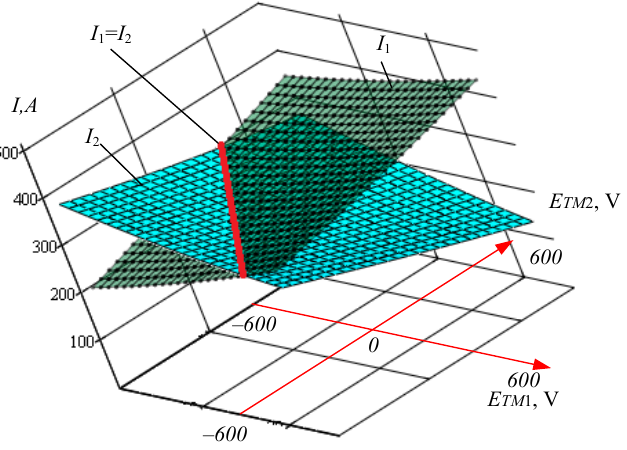
The DN power flow transmission parameters have been calculated (Figure 7) for voltage magnitude, phase angle, and combined control modes. Figure 14 shows the ranges of real and reactive power changes of power lines with currents I 1 , I 2 , and I 3 under the combined control mode. Figure 13. Change in currents I 1 and I 2 under combined control mode and constant load.